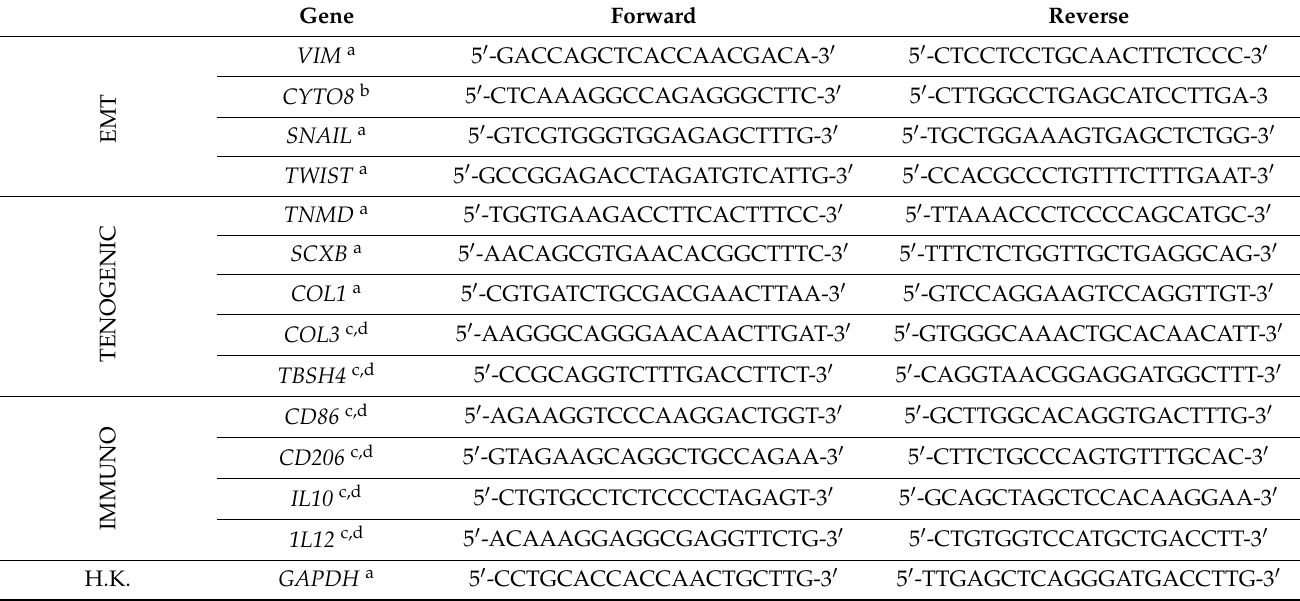
Table 1. Primers details used for RT-qPCR